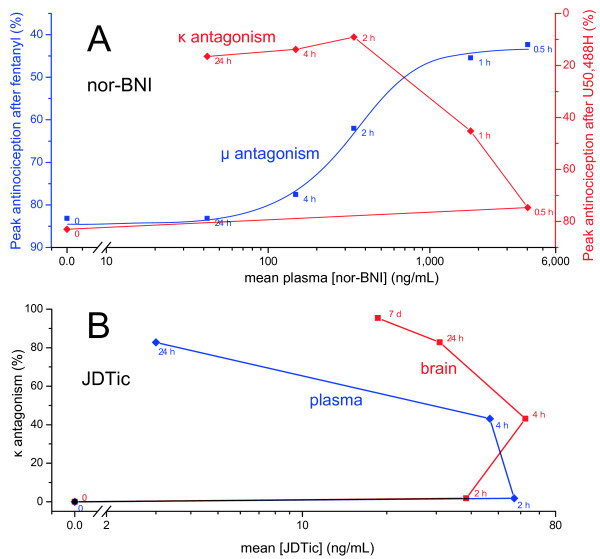
Concentration-effect relationships derived from Figures 5 and 6. A: Plasma nor-BNI concentrations against reported μ and κ antagonism at the indicated times (mice, 20 mg kg−1 s.c. [10]). B: Plasma and brain JDTic concentrations against reported κ antagonism (mice, i.g. [15]).